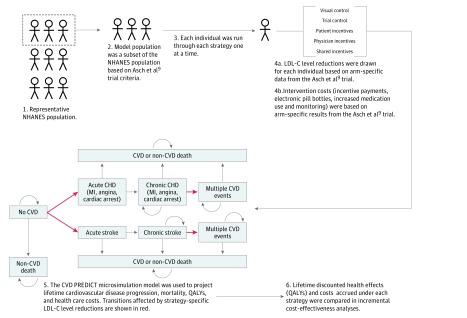
Schematic of Model-Based Cost-effectiveness AnalysesThe schematic provides an overview of the model population (steps 1 and 2), modeling approach (steps 3-5), and cost-effectiveness analysis (step 6). Individuals started the microsimulation model (step 5) in either the no cardiovascular disease (CVD), chronic coronary heart disease (CHD), or chronic stroke health states depending on their disease history. The curled arrows indicate that simulated patients in the model can stay in the same disease state in the next model cycle. LDL-C indicates low-density lipoprotein cholesterol; MI, myocardial infarction; NHANES, National Health and Nutrition Examination Survey; and QALY, quality-adjusted life-year.